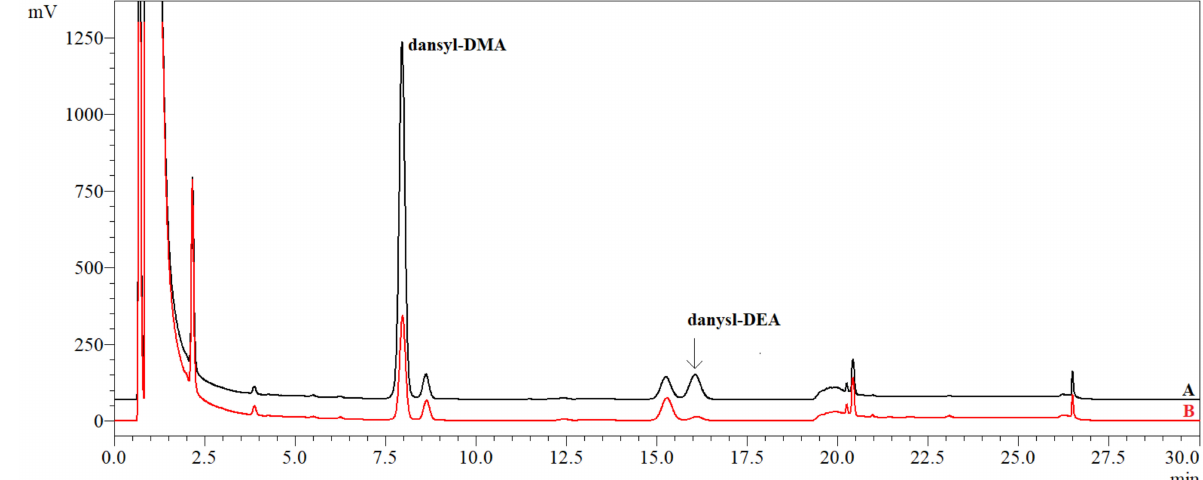
Figure 3. Chromatogram of the 4- µ g/g standard solution ( A ) and the blank sample ( B ) after derivatisation with dansyl chloride (chromatographic conditions as in Table